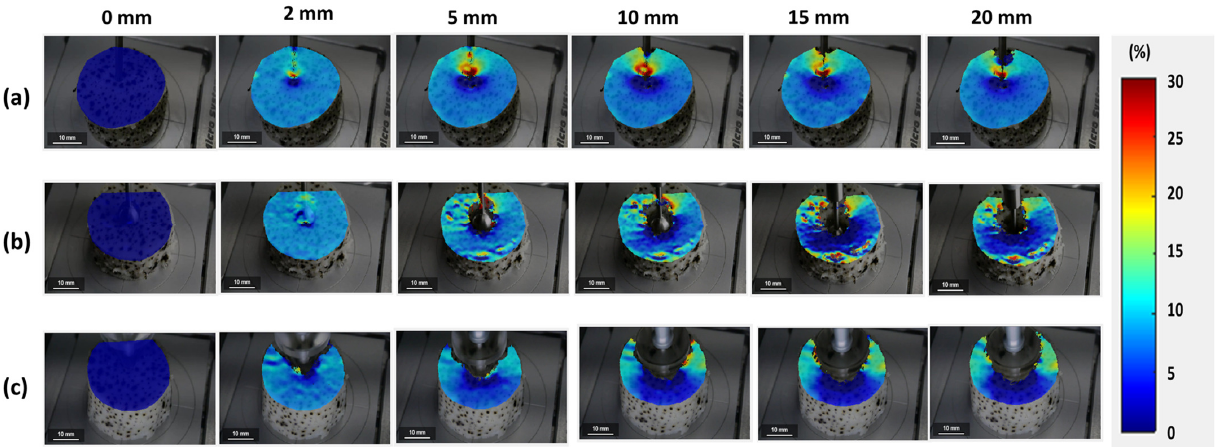
Figure 2. Contour plots of the strain component of surimi gel during a penetration test using ( a ) a cylindrical probe, ( b ) a spherical probe, and ( c ) a conical probe.